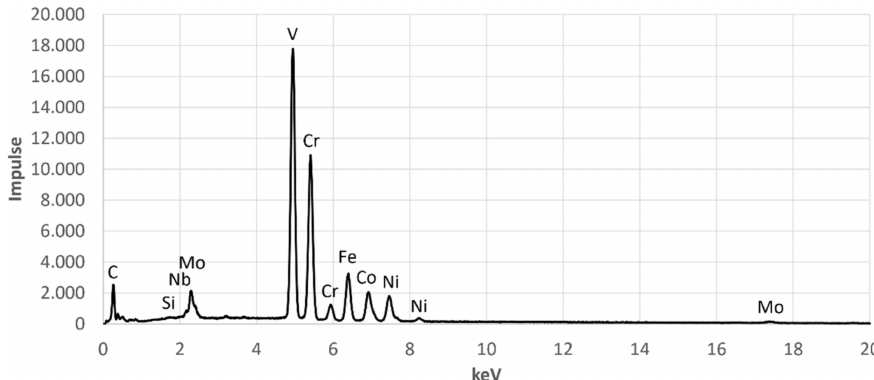
Figure A1. EDX-Spectrum for EDX Point 1.